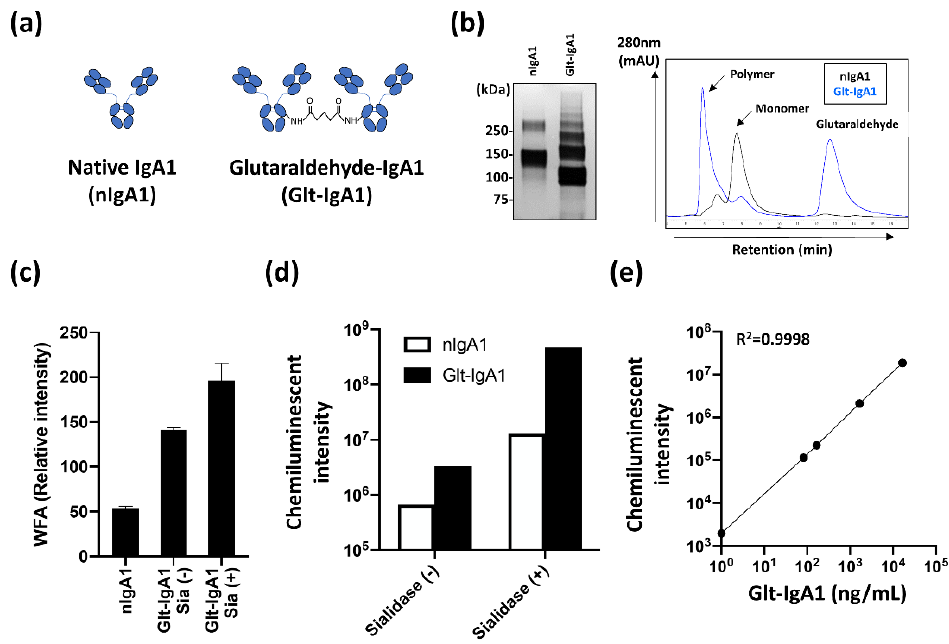
Figure 3. Construction and evaluation of standard IgA1 for automated immunoassay system. ( a ) Illustrations of mono (nIgA1) and polymeric IgA1 (Glt-IgA1) standards. ( b ) Evaluation of each IgA1 standard. SDS-PAGE and silver stain were performed under the non-reducing condition. The standards were analyzed by size exclusion chromatography. Black and blue lines indicate nIgA1 and Glt-IgA1, respectively. ( c ) WFA signals evident in differential glycan analysis with antibody-overlay lectin microarray of standards. nIgA1 represents without sialidase digestion Glt-IgA1 Sia (+) and Sia ( − ) denotes presence and absence, respectively, of sialidase digestion. ( d ) Differential measurements of constructed standard IgA1 by HISCL an automated chemiluminescent immunoassay system. Each standard was compared with (+) or without ( − ) sialidase digestion. ( e ) Linear responsibility of chemiluminescent count and concentration of Glt-IgA1 with sialidase